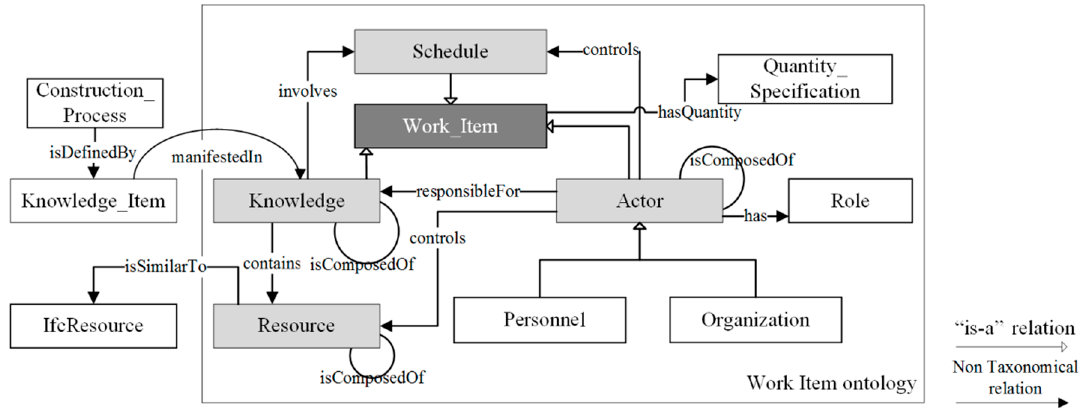
Figure 11. Work item ontology.